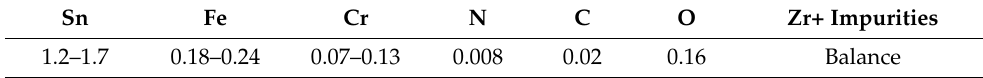
Table 1. Chemical composition (wt.%) of the Zr-4 cladding material used in this study